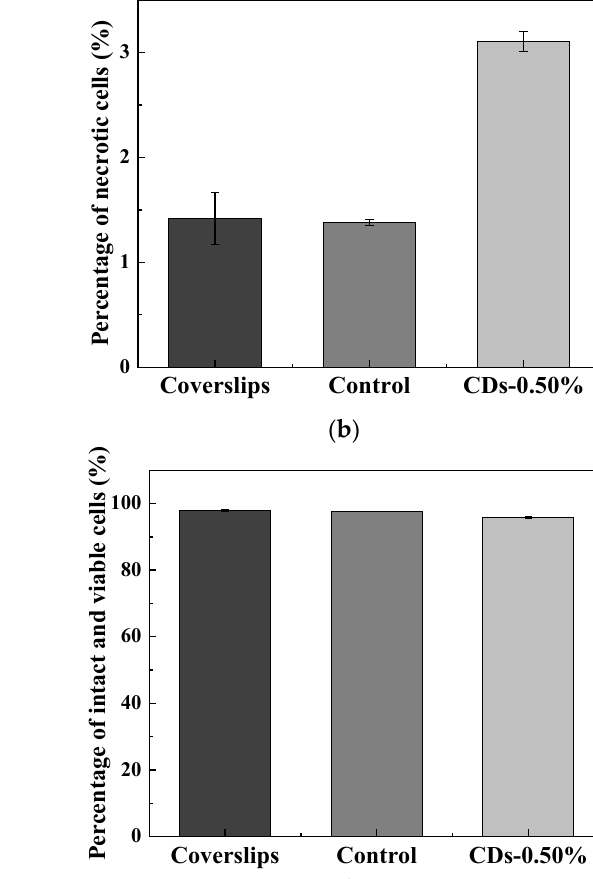
Figure 13. Apoptosis of L929 cells on silk scaffolds. ( a ) Viable apoptotic cells; ( b ) necrotic cells; ( c ) total apoptotic cells; ( d ) intact and viable cells.